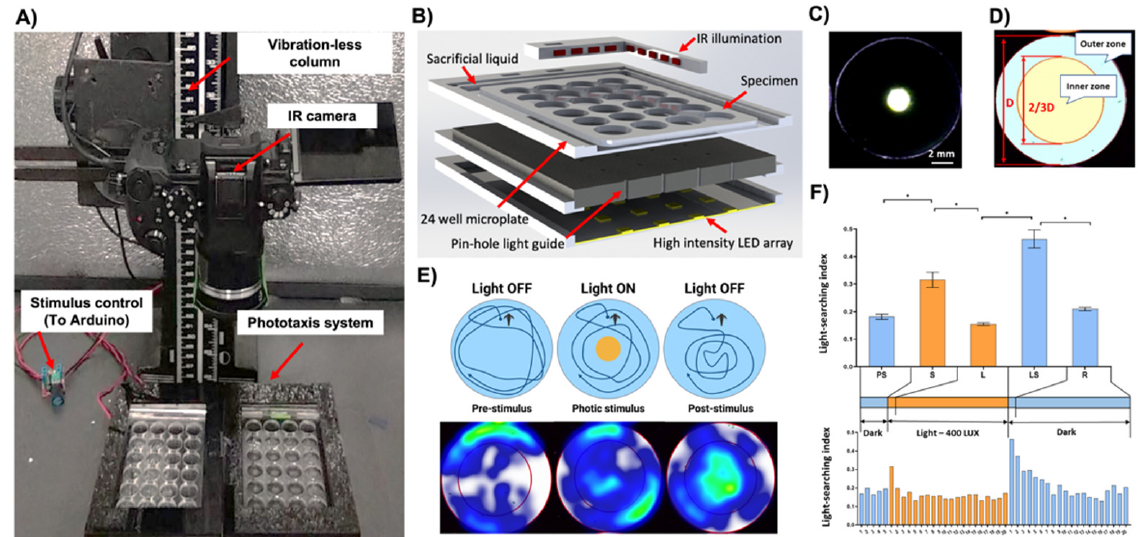
Figure 1. Design and validation of the high-throughput system for the analysis of phototactic behav- iors of Artemia franciscana . ( A ) A high-definition IR camera mounted on the vibration-less column to enable imaging of two 24-chamber custom test plates simultaneously; ( B ) Multi-layer construction of the phototaxis test plate with (i) orthogonal IR illumination, (ii) test chambers, (iii) pinhole light guide layer, (iv) LED light stimulus array; ( C ) The photic stimulus providing a narrow beam of light with only a discrete illuminated area at the epicenter of the chamber; ( D ) Bioinformatic analysis in animal tracking software to account for uniform volume and area size of the inner/outer regions and the relative occupancy of animals; ( E ) A cartoon and occupancy heatmaps depicting the behavioral responses including the light searching behaviors (LSBs) upon extinguishing of the photic stimulus; ( F ) Discrete aggregate behavioral fingerprints (top) with a corresponding and expanded time-resolved analysis (bottom). PS—pre-stimulus (light OFF), S—startle (light ON), L—adaptation to light (Light ON), LS—light searching behaviors (light OFF), R—recovery (light OFF). At least four independent experiments were performed, averaging data from up to 240 specimens. * p < 0.05 one-way ANOVA.